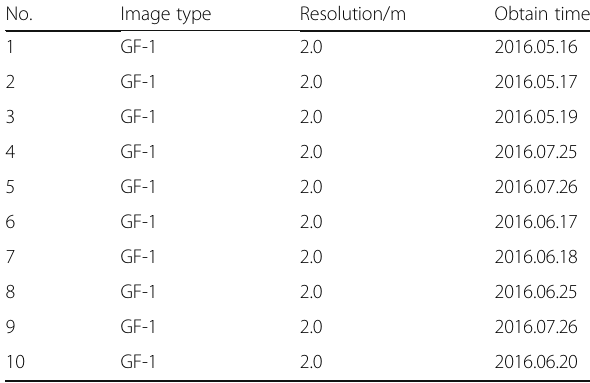
Table 1 Parameter of remote sensing